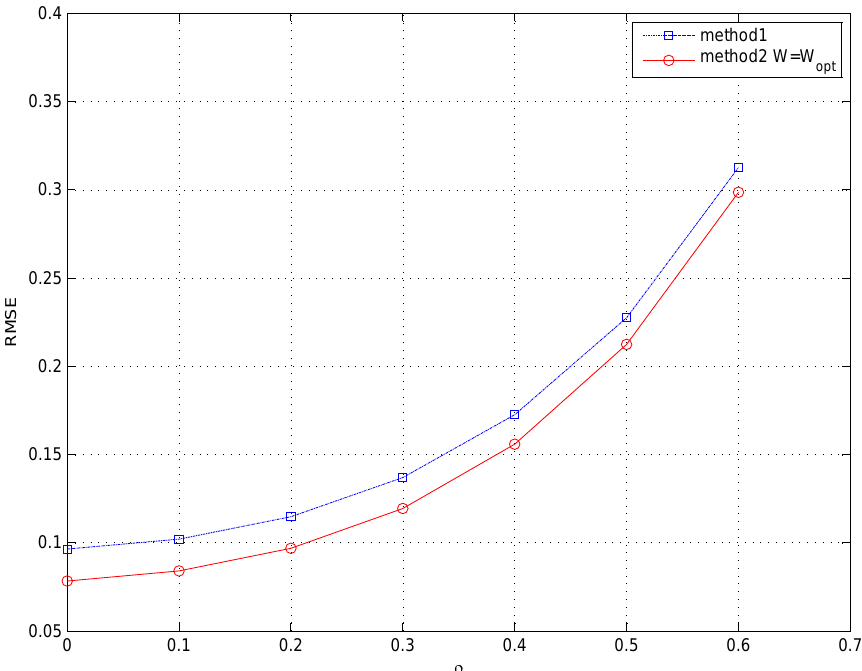
Figure 4. RMSE of the spatial signature matrix V estimation versus correlation factor ρ . The number of snapshots N = 1000 and SNR = 15